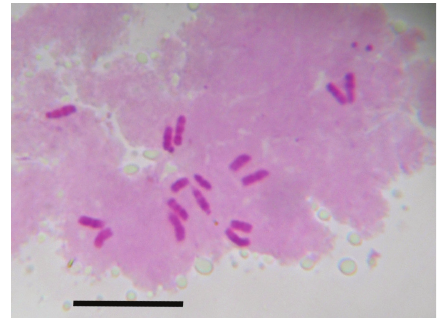
Figure 4. Carduus nutans L. subsp. perspinosus (Fiori) Arènes, 2 n = 16. Scale bar: 10 μm.